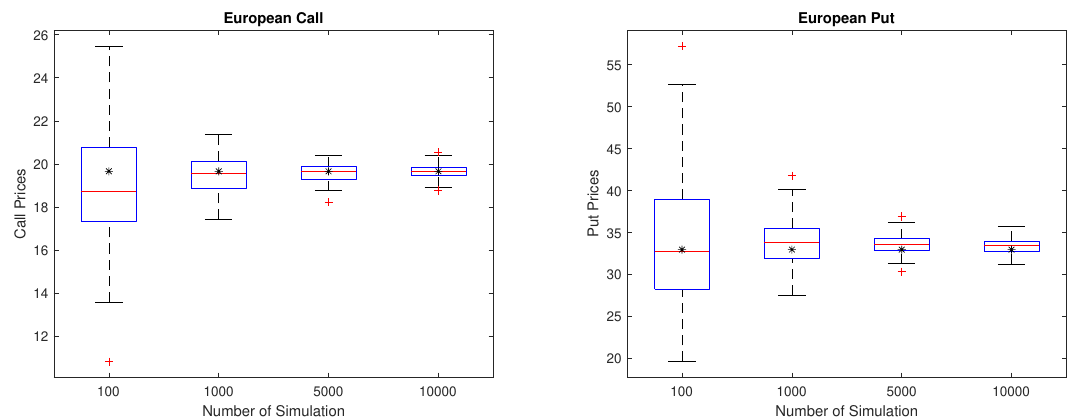
Figure 5. Bootstrapping for call ( left ) and put ( right